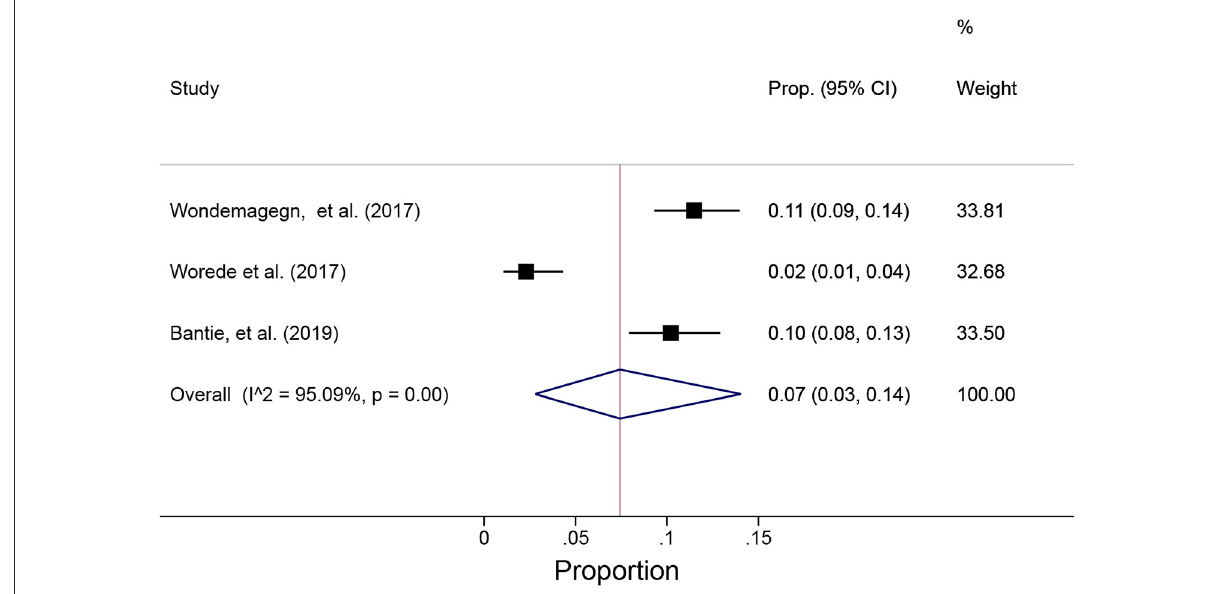
FIGURE3 Shows the pooled prevalence of undiagnosed DM using the random effect